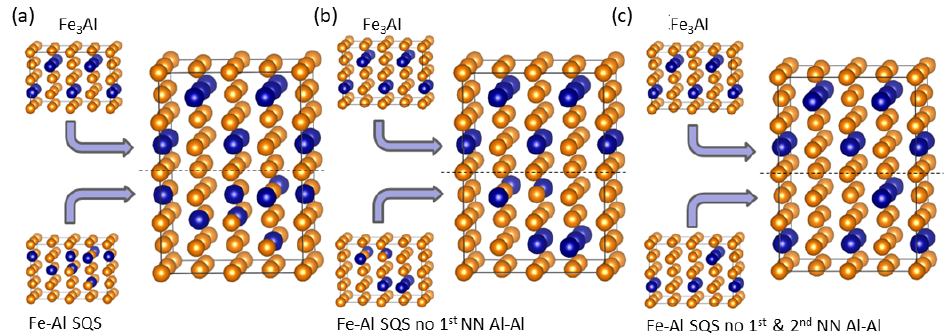
Figure 7. Visualization of nanocomposite supercells for the (001) interface plane. The figures show how the Fe 3 Al intermetallic compound is combined with different models of the Fe-Al phase with 18.75 at.% Al, in particular the general SQS (A2-like) model ( a ), the SQS model without the 1st NN Al-Al pairs, B2-like, ( b ) and the SQS without the 1st and 2nd NN Al-Al pairs, D0 3 -like ( c